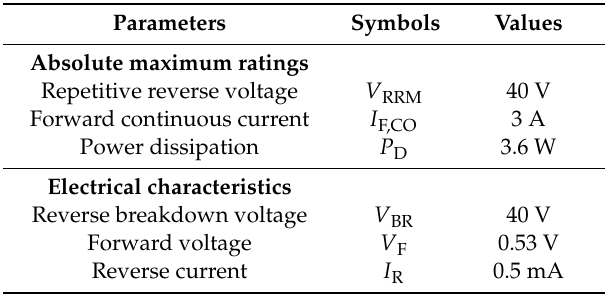
Table 3. 1N5822 Schottky diode (D1–D4) specifications.